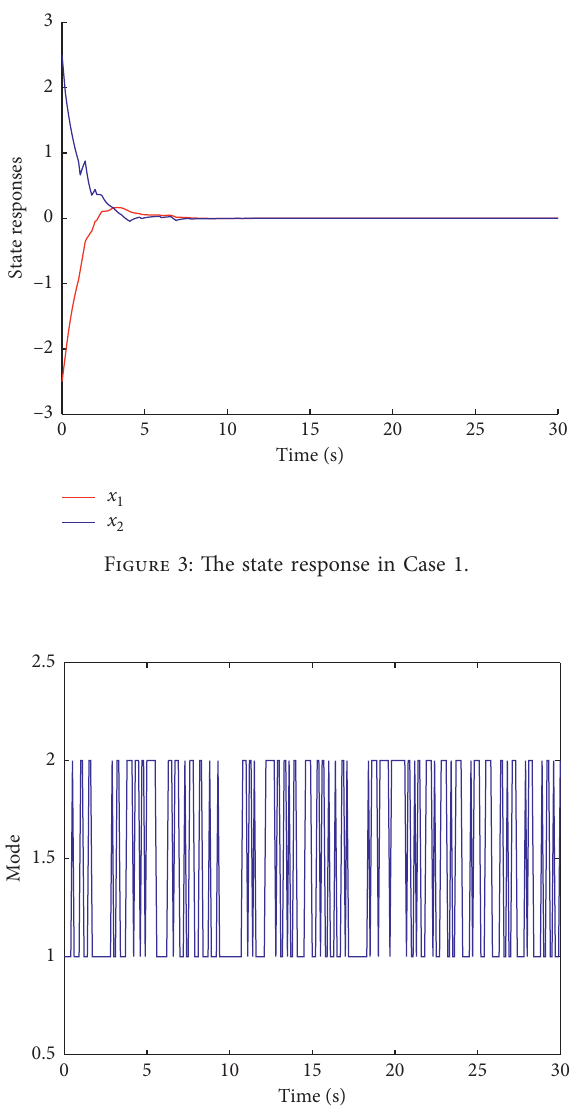
Figure 4: The state transition of Markov jump in Case 2.